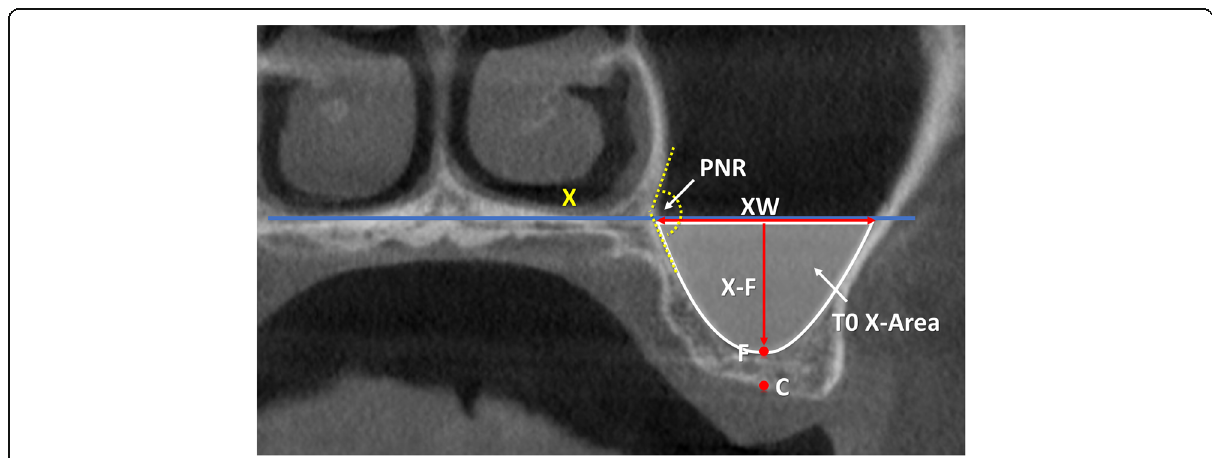
Fig. 1 T0, coronal view of a no-membrane CBCT; X, line drawn following the floor of the nose; C, center of the bony crest; F, base of the sinus floor; PNR, palatal-nasal recess. X-F, nasal floor height; XW (sinus width), distance evaluated on the line X between the two intersection points with the medial and lateral sinus bone walls; T0 X-Area, area delimited by the sinus bone walls and the line X. The PNR angle is indicated in